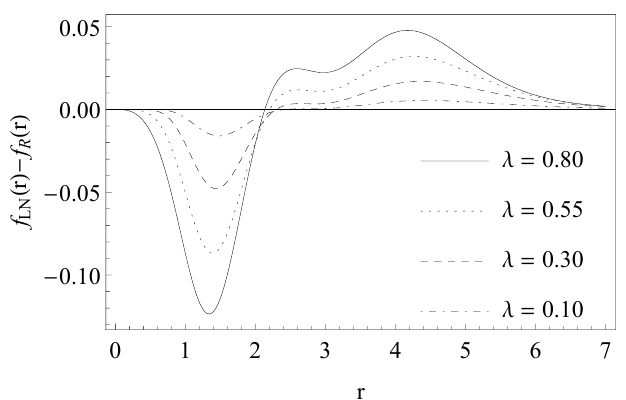
Figure 1. Comparing the Lognormal distribution and the corresponding α - µ